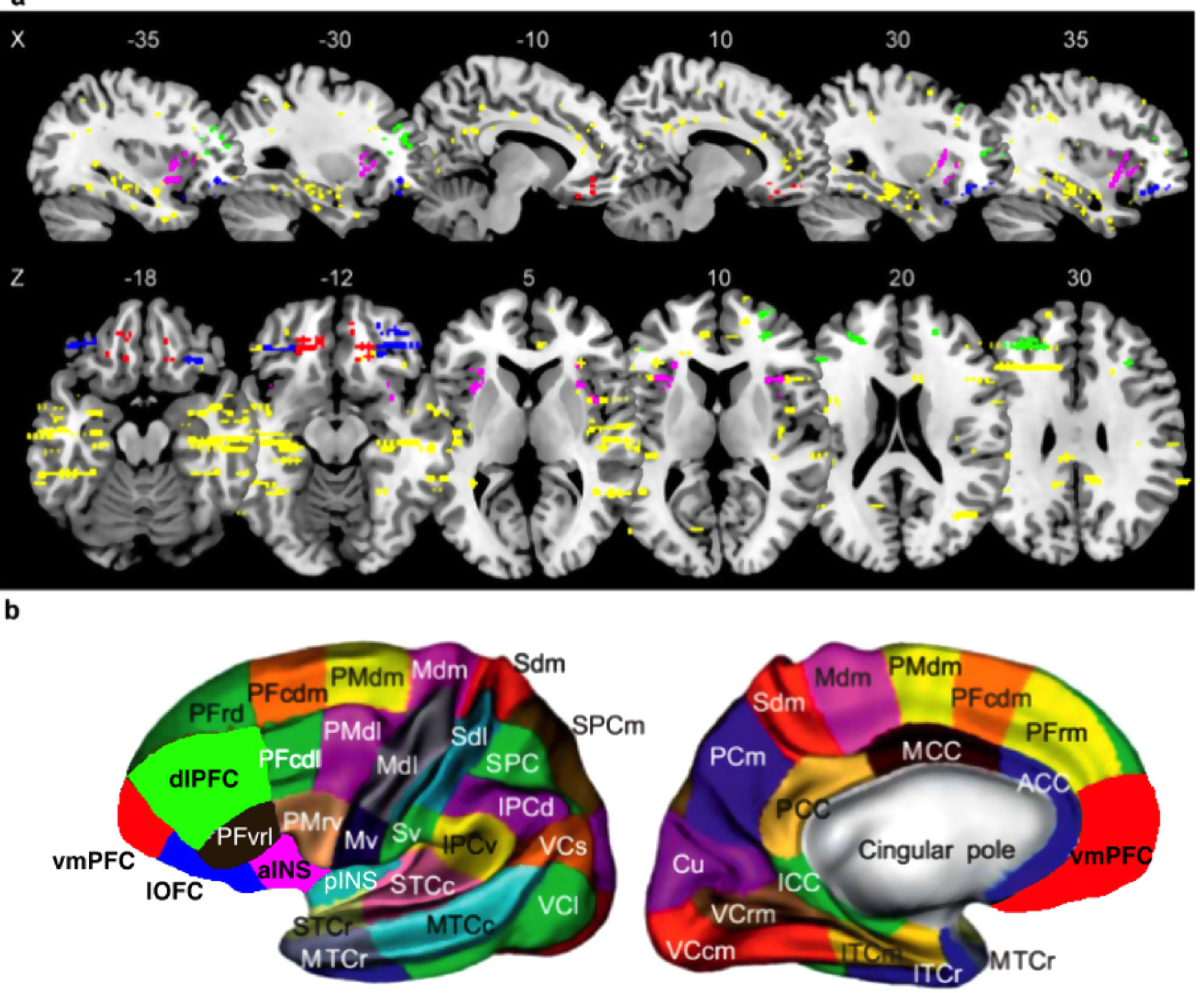
Fig. 2 Anatomical location of intracerebral electrodes. a Sagittal and axial slices of a brain template over which each dot represents one iEEG recording site ( n = 1694). Color code indicates location within the four main regions of interest (red: vmPFC, n = 54; green: dlPFC, n = 74; blue: lOFC, n = 70; purple: aINS, n = 83). b MarsAtlas parcellation scheme represented on an in fl ated cortical